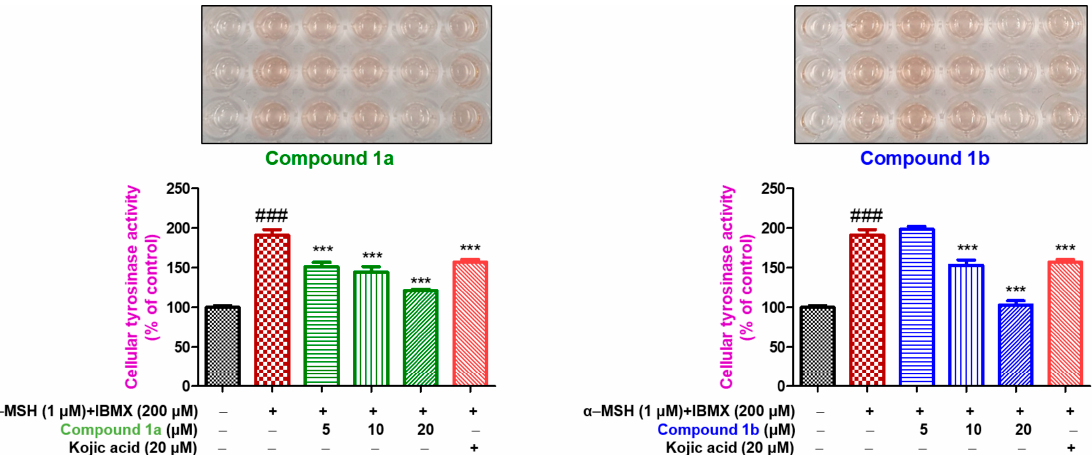
Figure 10. Inhibitory effects of 1a and 1b on tyrosinase activity of B16F10 cells co-treated with IBMX and α -MSH. B16F10 cells were treated with 1a (5, 10, or 20 μ M) or 1b (5, 10, or 20 μ M). As the positive control, kojic acid (20 µ M) was used. Cellular tyrosinase activities are presented as percentages of untreated controls, and bars indicate standard errors. The symbols * and # indicate significant differences between groups: ### p < 0.001 for untreated controls versus IBMX and α -MSH-stimulated cells; *** p < 0.001 for cells co-stimulated with IBMX and α -MSH versus cells co-stimulated with IBMX and α -MSH and treated with compound 1a , 1b , or kojic acid. Experiments were